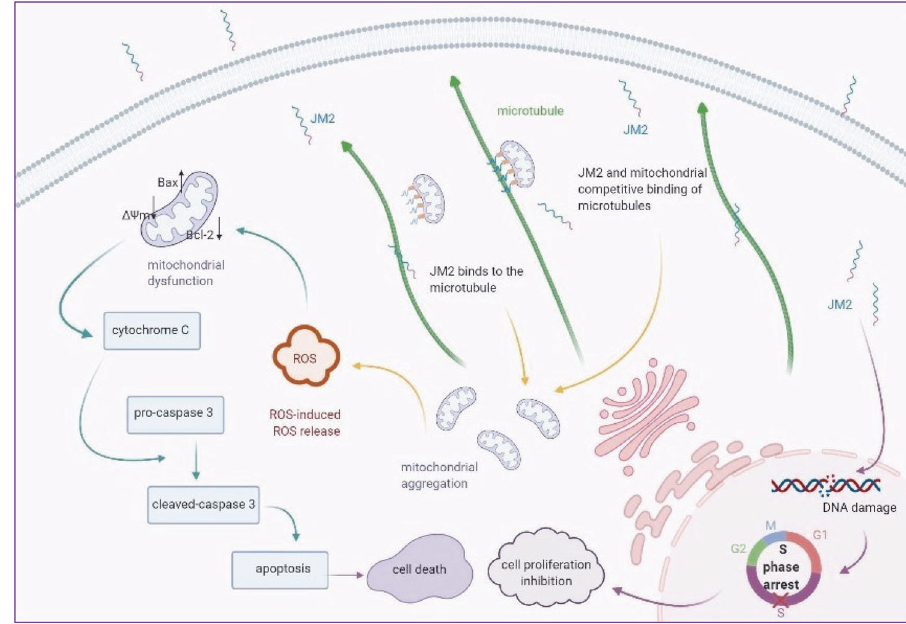
Fig. 8 The anti-tumor mechanism of JM2. Illustration of possible molecular mechanism of JM2 applied to tumor